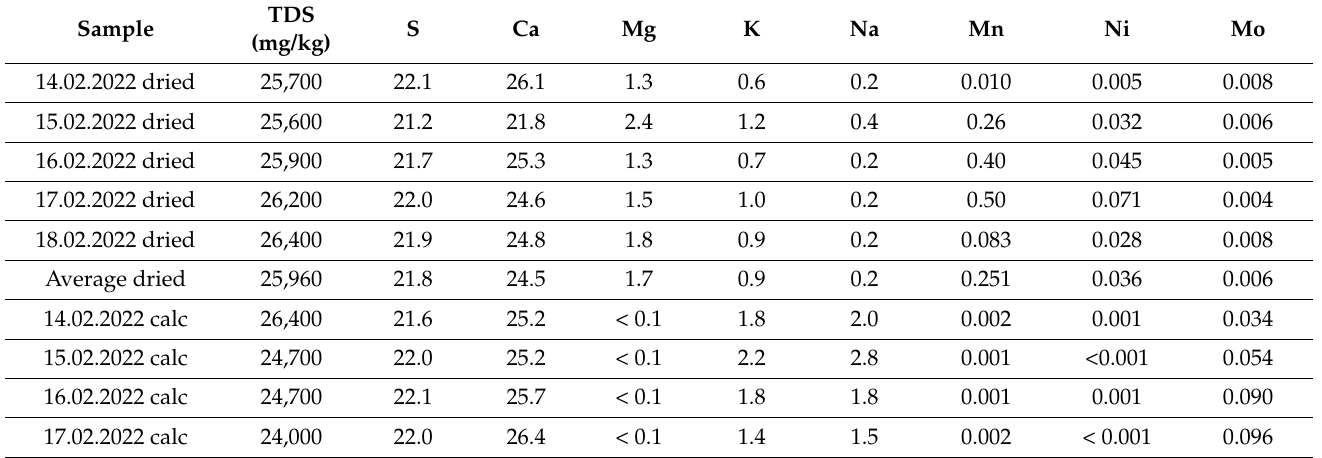
Table 5. Results of the water leaching expressed in terms of total solids and their chemical